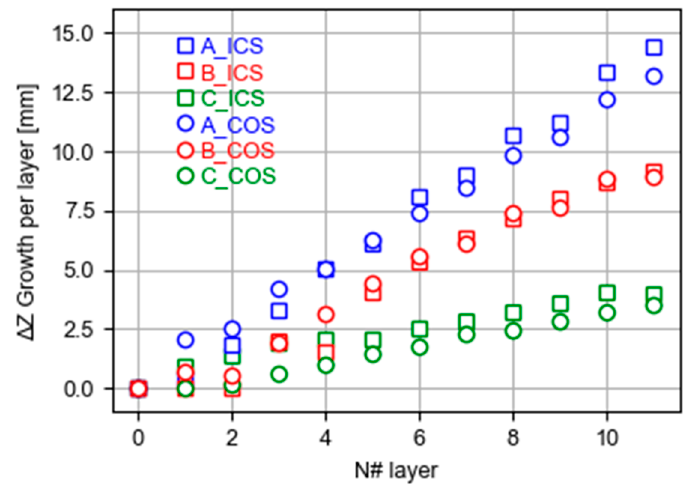
Figure 8. Growth per layer according to the deposition condition and cooling strategy .